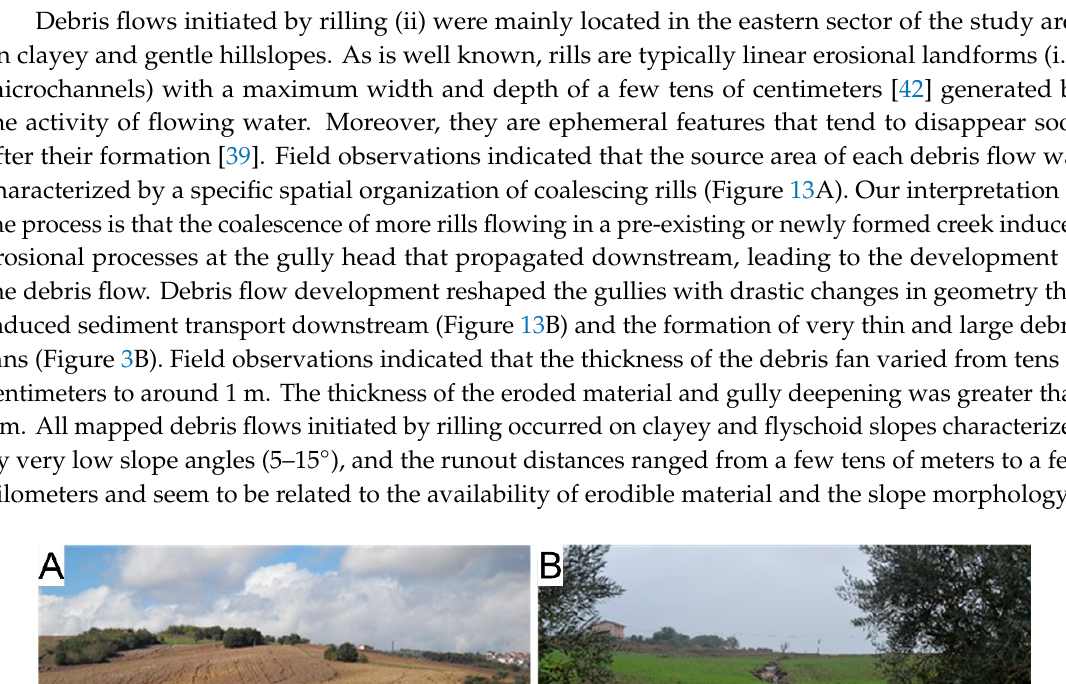
Figure 12. Slope instabilities triggered on slopes: ( A ) Earth flow; ( B ) runoff-generated debris flow in the town of Paupisi; ( C ) poorly sized work in a channel; ( D ) runoff-generated debris flow deposit.